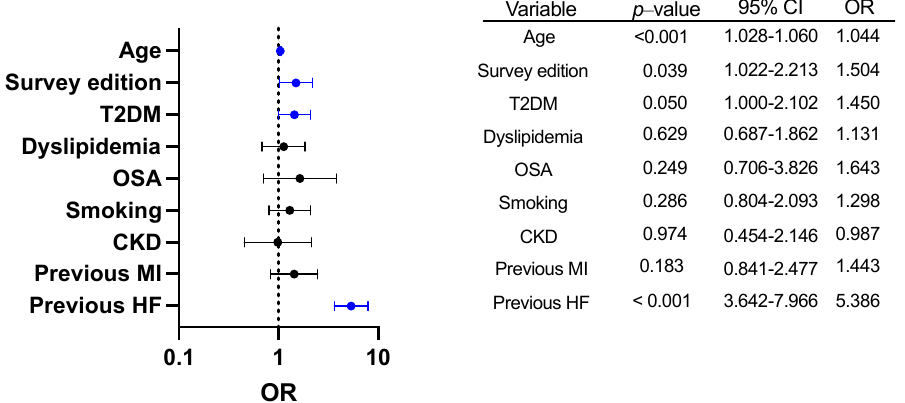
Figure 4. Multivariable logistic regression model including typical AF-inducing risk factors in hypertensive patients. Independent predictors in multivariable logistic regression analysis for AF status (age, survey edition, previous HF, T2DM) are highlighted in blue. Error bars denote 95% confidence intervals for odds ratio (OR). T2DM = type 2 diabetes mellitus, OSA = obstructive sleep apnea, CKD = chronic kidney disease, MI = myocardial infarction, HF = heart failure, AF = atrial fibrillation.